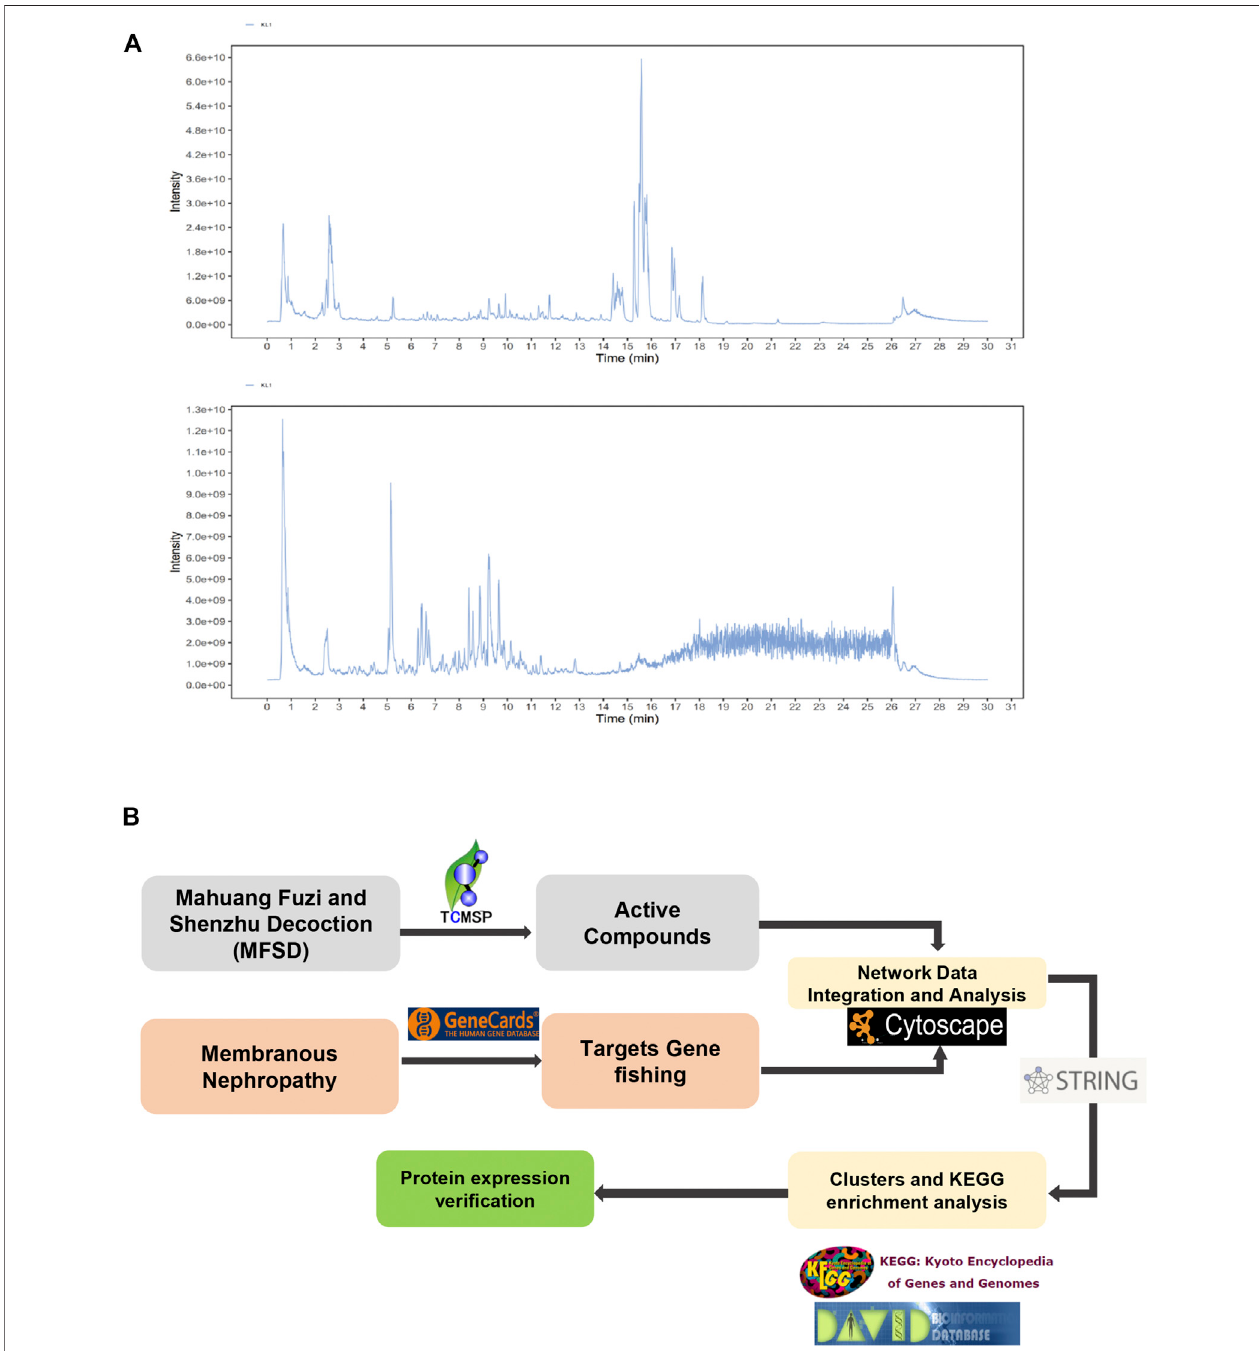
FIGURE 3 | Analysis of the target of MFSD based on network pharmacology (A) UPLC-MS Assay of the concentration of MFSD. (B) Schematic fl ow chart of network pharmacology analysis of target of MFSD.